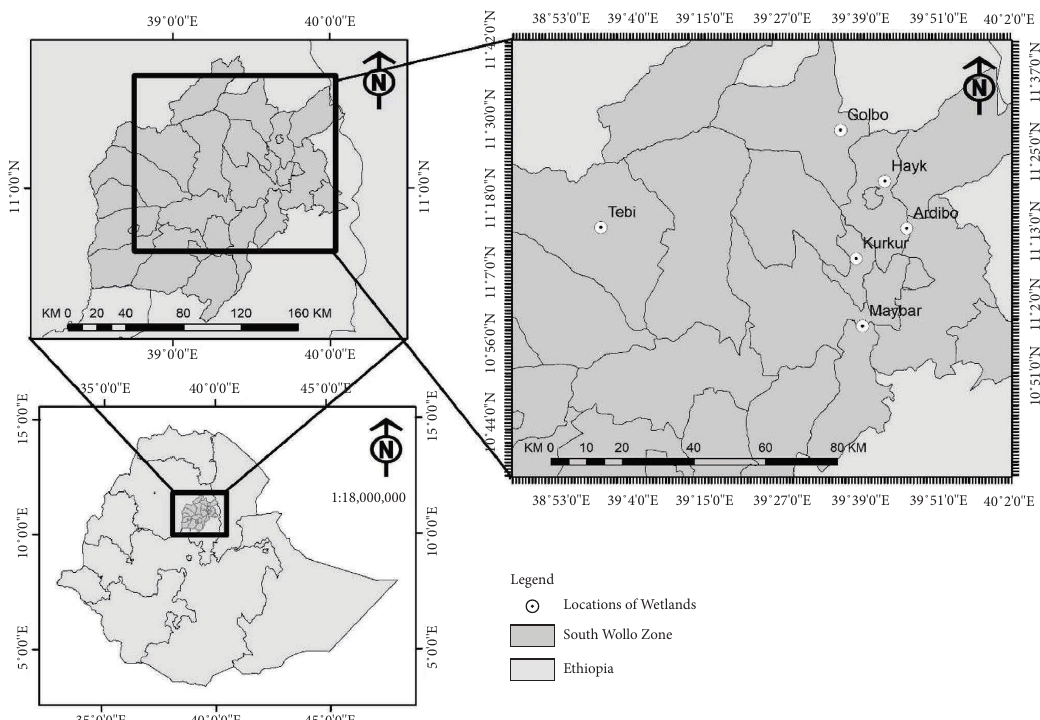
Figure 1: Some wetlands of South Wollo Zone produced by GIS and Google Earth (source: